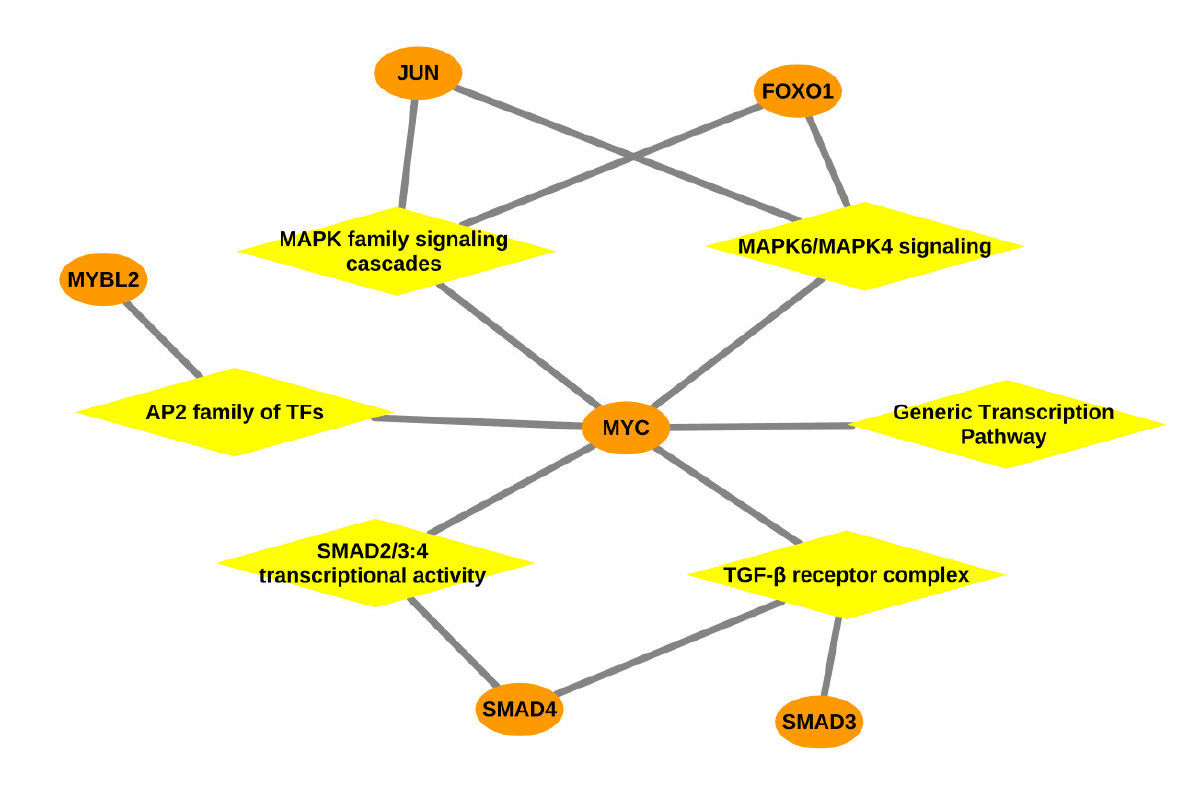
Figure 5. Gene-pathway network: Network representing the association between the over-represented pathways and transcription factors especially MYC , depicted for the lymph node tissue of Boran. Orange coloured ellipses in the network represent the transcription factor genes and yellow coloured rhombuses indicate the over-represented pathways. The transcription factors are connected to the pathways, thereby forming a network of interactions between